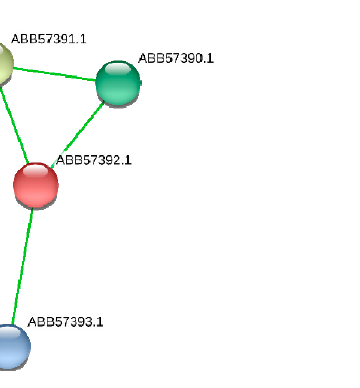
Figure 3. Network of ABB57392.1 protein ( Synpcc7942_1362 ) and its protein partners according to STRING (https://string-db.org). In this figure: ( 1 ) protein ABB57391.1 ( Synpcc7942_1361 ) is a